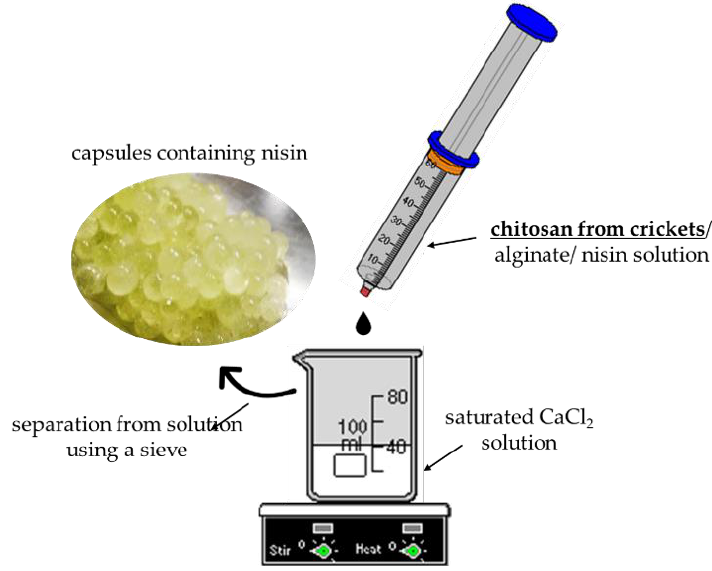
Figure 2. A scheme of a synthesis of polymer capsules. 2.5.3. Studies on the Release of Nisin from Capsules in Different Environments Release profiles of nisin from the interior of chitosan/alginate-based capsules and alginate-based capsules were determined in two different environments. First environment simulated conditions occurring in human stomach—study was conducted in 2% citric acid solution (pH ~ 2); second one resembled pH which is characteristic for duodenum—such conditions were simulated by phosphate buffer (pH = 7.4). Study was carried out as follows: a suitable amount of capsules containing the highest amount of nisin solution (5 mL) were introduced into sterile vessels containing 200 mL of 2% citric acid and PBS solution and placed on a shaking incubator (Hanchen ES-60E Temperature Controlled Incubator and Shaker Scientific Incu-Shaker Shaking Incubator). Vessels were tightly closed with parafilm to limit the possible impact of the external environment. The release process was performed at 37 ◦ C so at the temperature simulating conditions occurring in human body and at a shaking speed of 80 rpm. After every 15 min 3 mL of tested solution were taken, introduced into the cuvette and concentration of active substance in tested sample was determined using UV-Vis spectrophotometry (spectrophotometer UV-Vis Thermo Scientific Evolution 201, Thermo Fischer Scientific, Waltham, MA, USA) wherein maximum absorbance characteristic for nisin was verified at approx. λ = 230 nm. Importantly, in each case after sampling the medium, in which the release process was performed, was supplemented with 3 mL of 2% citric acid or PBS solution so that the total volume of the release medium remained constant. To sum up, the study was conducted to verify the drug release ability of both chitosan/alginate-based capsules and alginate-based capsules in various environments simulating in pH and temperature conditions occurring in human body. This, in turn, allowed to determine conditions ensuring the most effective release of the active